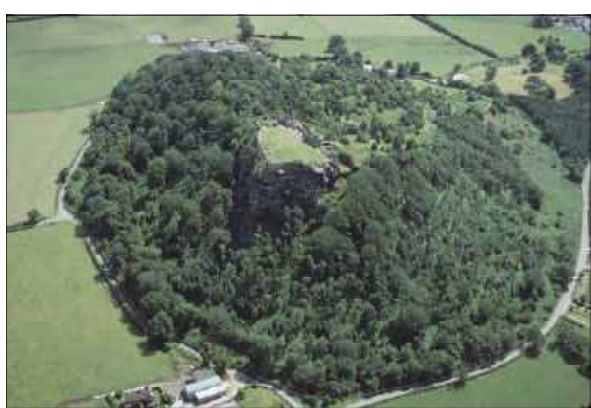
Fig 2.31 Beeston castle, Cheshire (National Museums Liver-